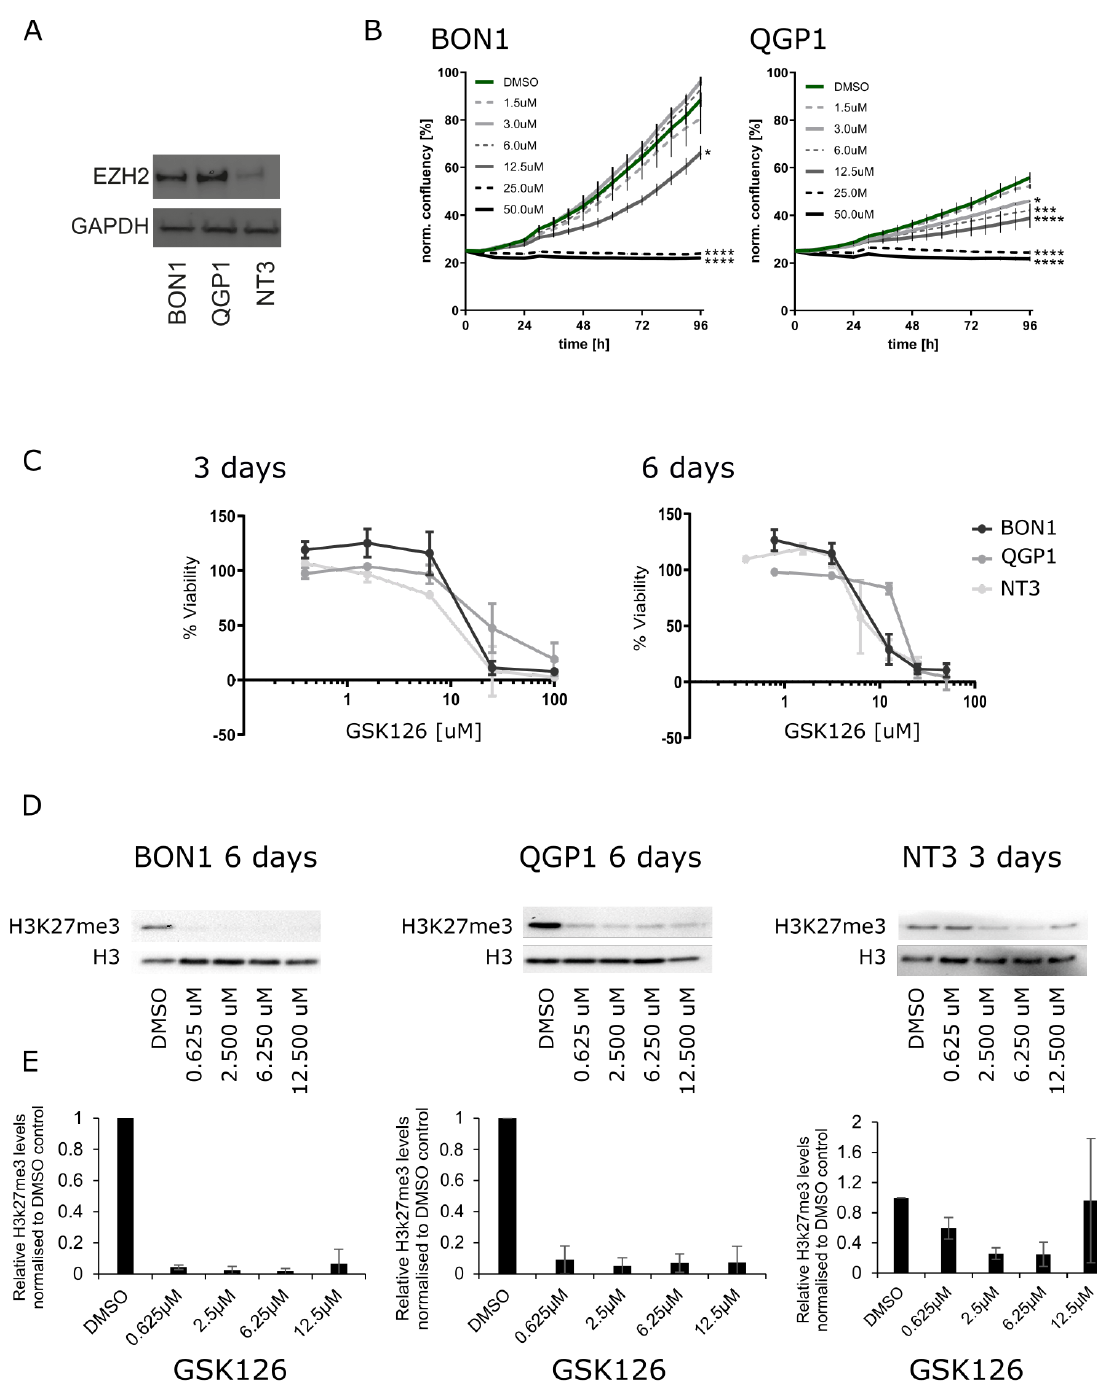
Figure 2. ( A ) Western blotting of EZH2 expression in PanNET cell lines: BON1, QGP1, and NT3. ( B ) IncuCyte S3 proliferation analysis of BON1 and QGP1 cells treated for 96 h with vehicle control (DMSO) and the indicated concentrations of GSK126. This is a representative result of two independent experiments. ( C ) MTT assays after EZH2 treatment with 0.62 µM, 2.5 µM, 6.255 µM, 12.5 µM, 25 µM, and 100 µM of GSK126 after 3 and 6 days. ( D ) Representative Western blotting of H3k27me3 after 6 days of treatment with 0.62 µM, 2.5 µM, 6.255 µM, and 12.5 µM GSK126 in BON1 and QGP1 and 3 days for NT3. Quantification of H3K27me3 levels normalized to H3 total based on three replicates.